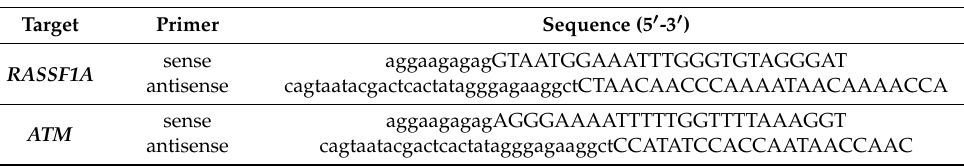
Table 6. Bisulfite-specific primers for the target amplicons.